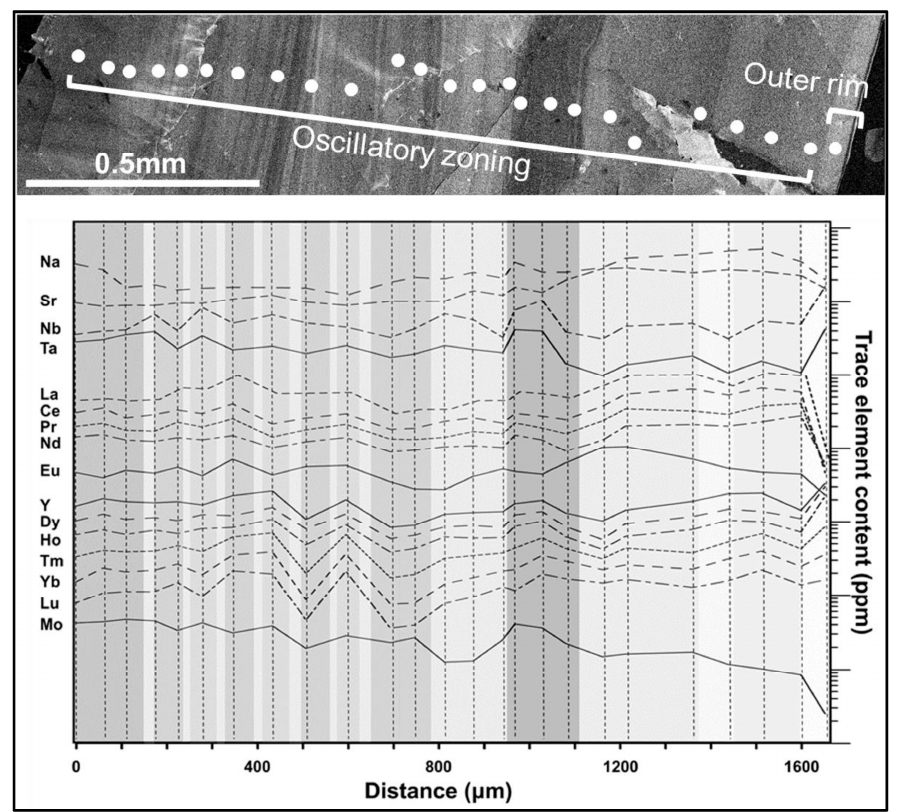
Figure 9 . Element trend plot along the oscillatory zones of stage I scheelite. Concentrations of each trace element are plotted with realistic scale. This graph provides information about behavior characteristics of each trace